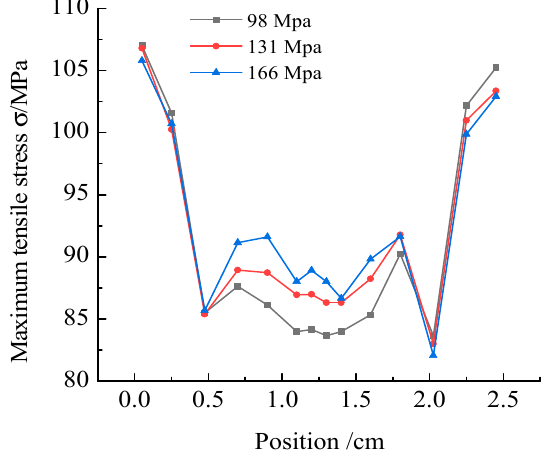
Figure 14. Variation of stress at the top of track slab under di ff erent moduli of elasticity polymer lifting.